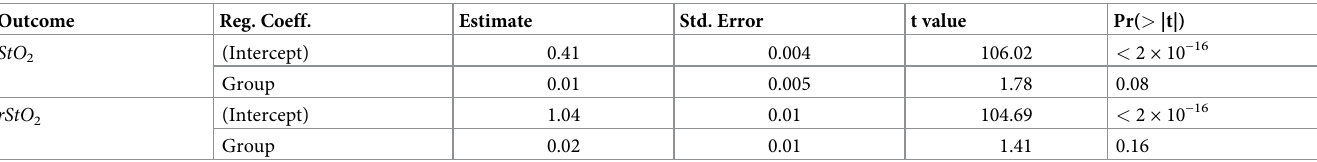
Table 2. The estimate of group effect in the SMM for StO 2 and rStO 2 at γ = 0.5. Outcome Reg. Coeff.